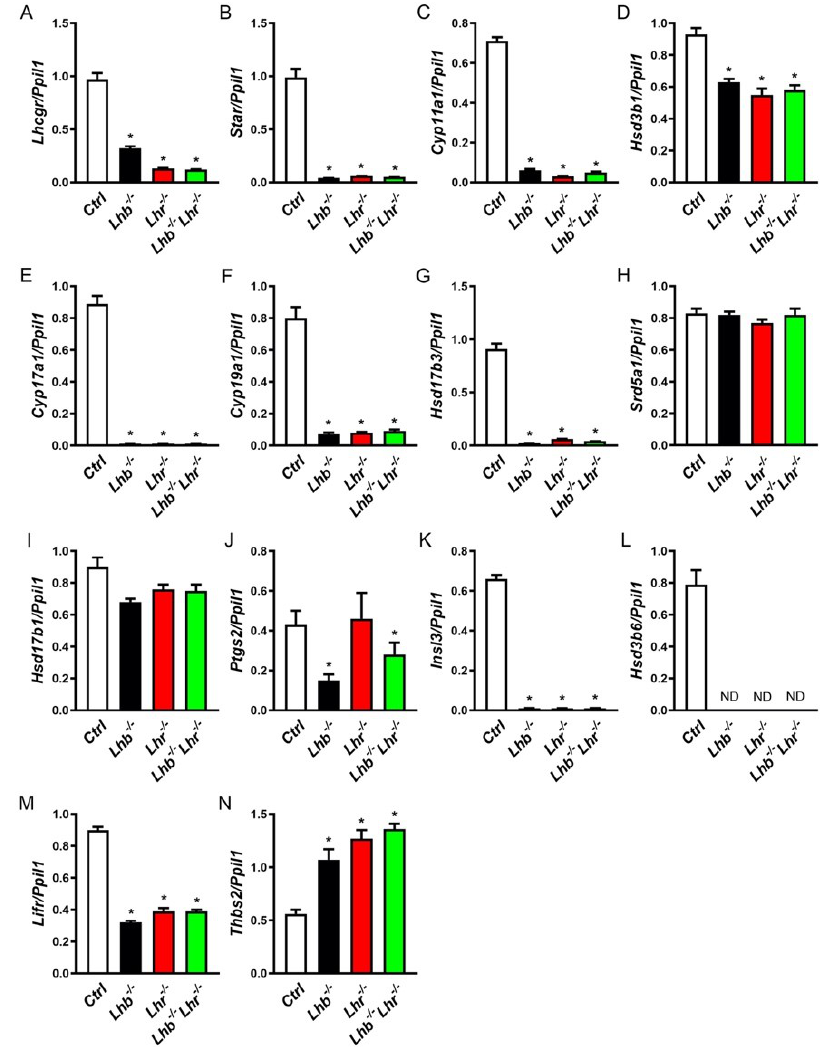
Figure 3. Taqman qPCR analysis of Leydig cell marker genes. Expression of Leydig cell marker genes was quantified in testis samples obtained from adult male mice (n = 3 – 4) at 56d of age. Expression of almost all of the selected mature Leydig cell genes was suppressed in the absence of only LH or LHR or both compared to that in Ctrl group but is similar among single and double mutants. Srd5a1 expression was unaffected in the absence of LH-LHR signaling ( H ). Expression of Hsd17b1 showed a trend towards suppression ( I ). Adult Leydig cell progenitor marker gene Lifr was suppressed in single or double mutants compared to that in Ctrl ( M ). Expression of Thbs2 was significantly upregulated in single and double mutants compared to Ctrl ( N ) indicating that fetal Leydig cells develop and accumulate in the absence of either only LH or LHR or both. ( A – N ) panels: * p < 0.05, One-way ANOVA , Ctrl vs. Lhb − / − or Lhr − / − or Lhb − / − Lhr − / − ; p > 0.05, One-way ANOVA, Lhb − / − vs. Lhr − / − or Lhb − / − Lhr − / − ; Lhr − / − vs. Lhb − / − Lhr − / − , in all panels except panel J, where a discordant expression was noted. For all qPCR assays, expression of Ppil1 was used as internal control and cDNA samples in triplicate were used from testis obtained from 3 mice.